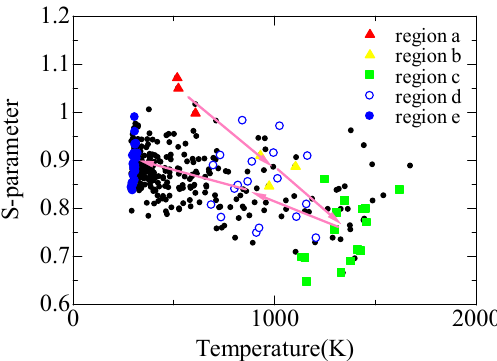
Figure 6. Temperatures and s-parameters of the laminar diffusion flame shown in Figure 5a,b. Propane molecules in region a collapses, which immediately coincides with soot generation in region b . The temperature increases up to 1500K and s-parameter decreases in region c where the combustion filed is dominated by CO 2 generation. Afterwards, the combustion gas mixes with air in region d . The temperature decreases and s-parameter converges to the value of the air (region e ).